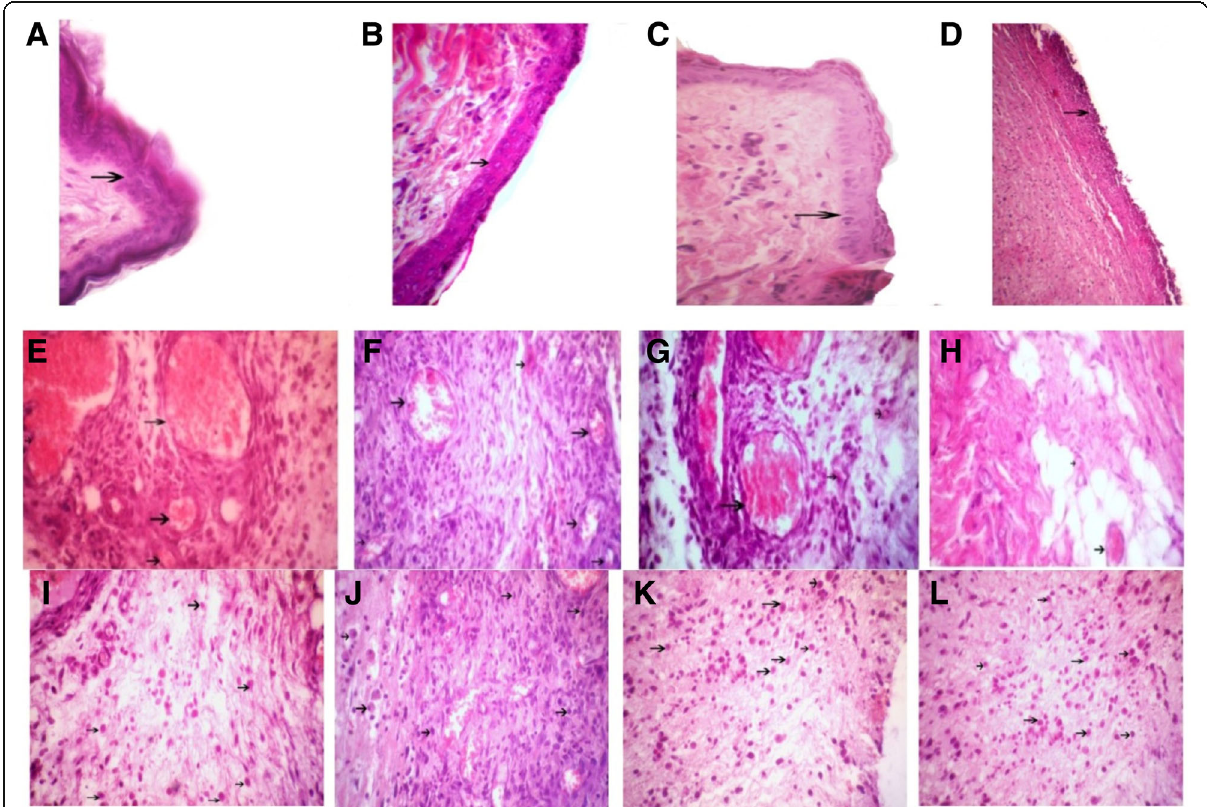
Fig. 5 Arrows show the wound epidermis regeneration ( a – d ), vascular formation ( e – h ), and granulation ( i – l ) on the third day. a , e, i Satureja khuzistanica -treated group. b , f , j Hydrogel alginate-treated group. c , g , k Satureja khuzistanica encapsulated in hydrogel alginate-treated group. d , h , l Control group. Hematoxylin and eosin stain (× 400). Arrows show the re-epithelialization with mild hyperplasia of the epidermis and moderate hyperkeratosis ( a – d ) and immature granulation tissue ( i – l ) with emerging blood vessels (angiogenesis) shown in black arrows and fibroblasts and numerous